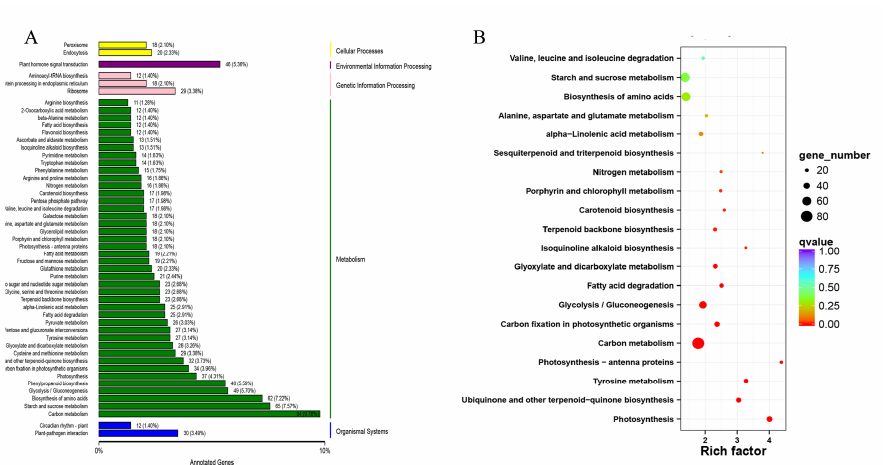
Figure 4. ( A ) KEGG classification of DEGs. The X -axis indicates the percentage of the annotation genes, and the Y -axis represents the KEGG pathway. ( B ) KEGG pathway enrichment of DEGs for the Figure 4. (A) KEGG classification of DEGs. The X-axis indicates the percentage of the annotation comparison of roots vs. leaves. The X -axis indicates the enrichment factor and log10 of the Q-value. genes, and the Y-axis represents the KEGG pathway. (B) KEGG pathway enrichment of DEGs for the The Y-axis represents the di ff erent KEGG comparison of roots vs. leaves. The X-axis indicates the enrichment factor and log10 of the Q-value. The Y-axis represents the different KEGG pathways.